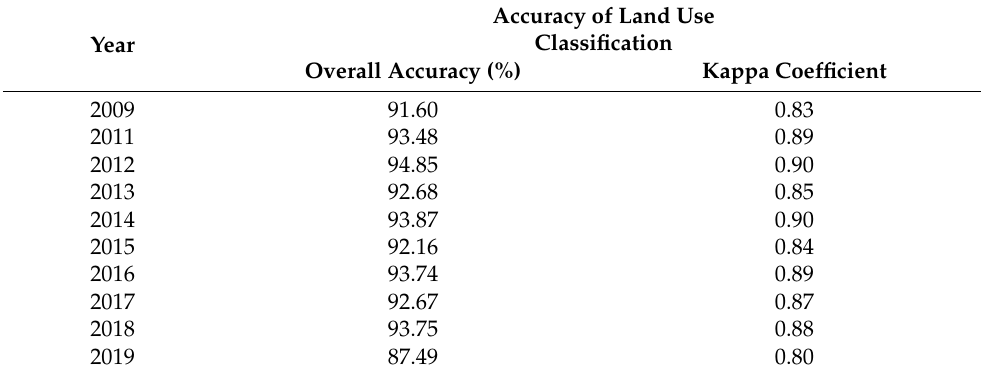
Table 2. Annual classification accuracy of annual winter